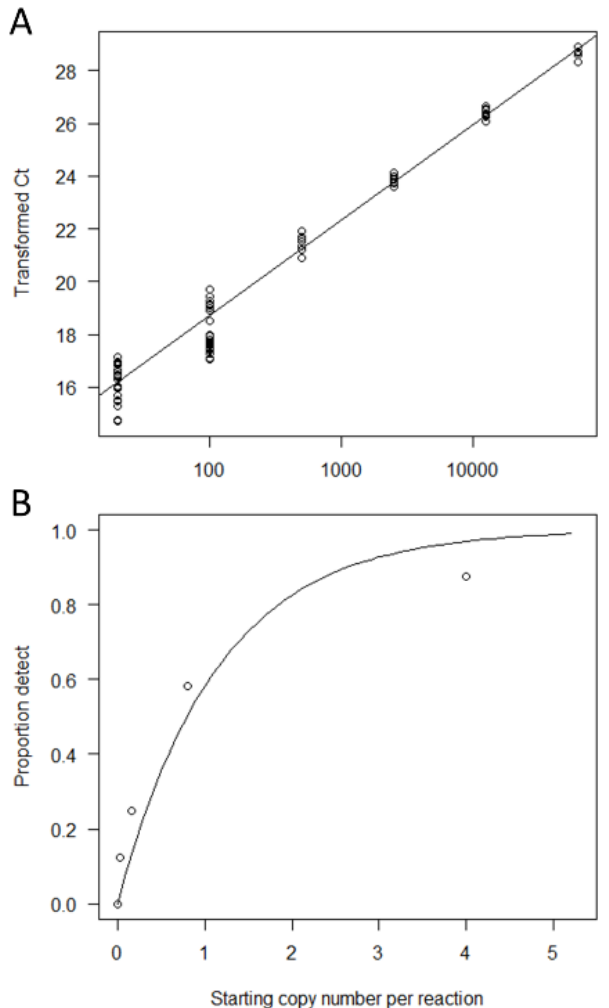
Figure 2. Calibration curves for the gBlock ® data for the coho salmon assay eONKI4. ( A ) Weighted linear regression model for high copy number concentrations where 100% of technical replicates returned a detection in the form of a C t value. This occurred at 20 copies/reaction. To facilitate compar- ison with the low copy number graph, transformed C t (50-C t ) are plotted. ( B ) Maximum likelihood fit model using eLowQuant Binomial–Poisson low copy number concentrations of ≤ 4